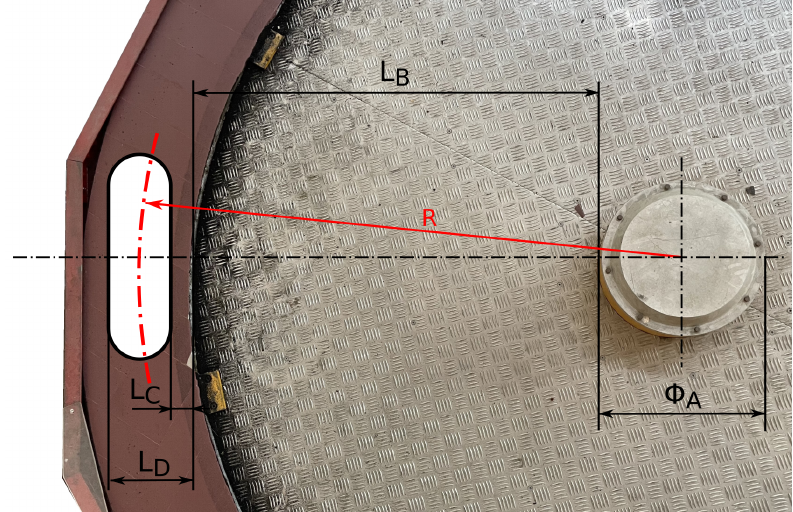
Figure 3. Top view of the tyre test rig. The path-curvature radius R is calculated through four measures, namely the rotating disk shaft diameter Φ A , the radial distance of the ring-shaped annular path from disk’s shaft L B and the radial positions L C and L D of the inner and outer sidewall of the tyre,